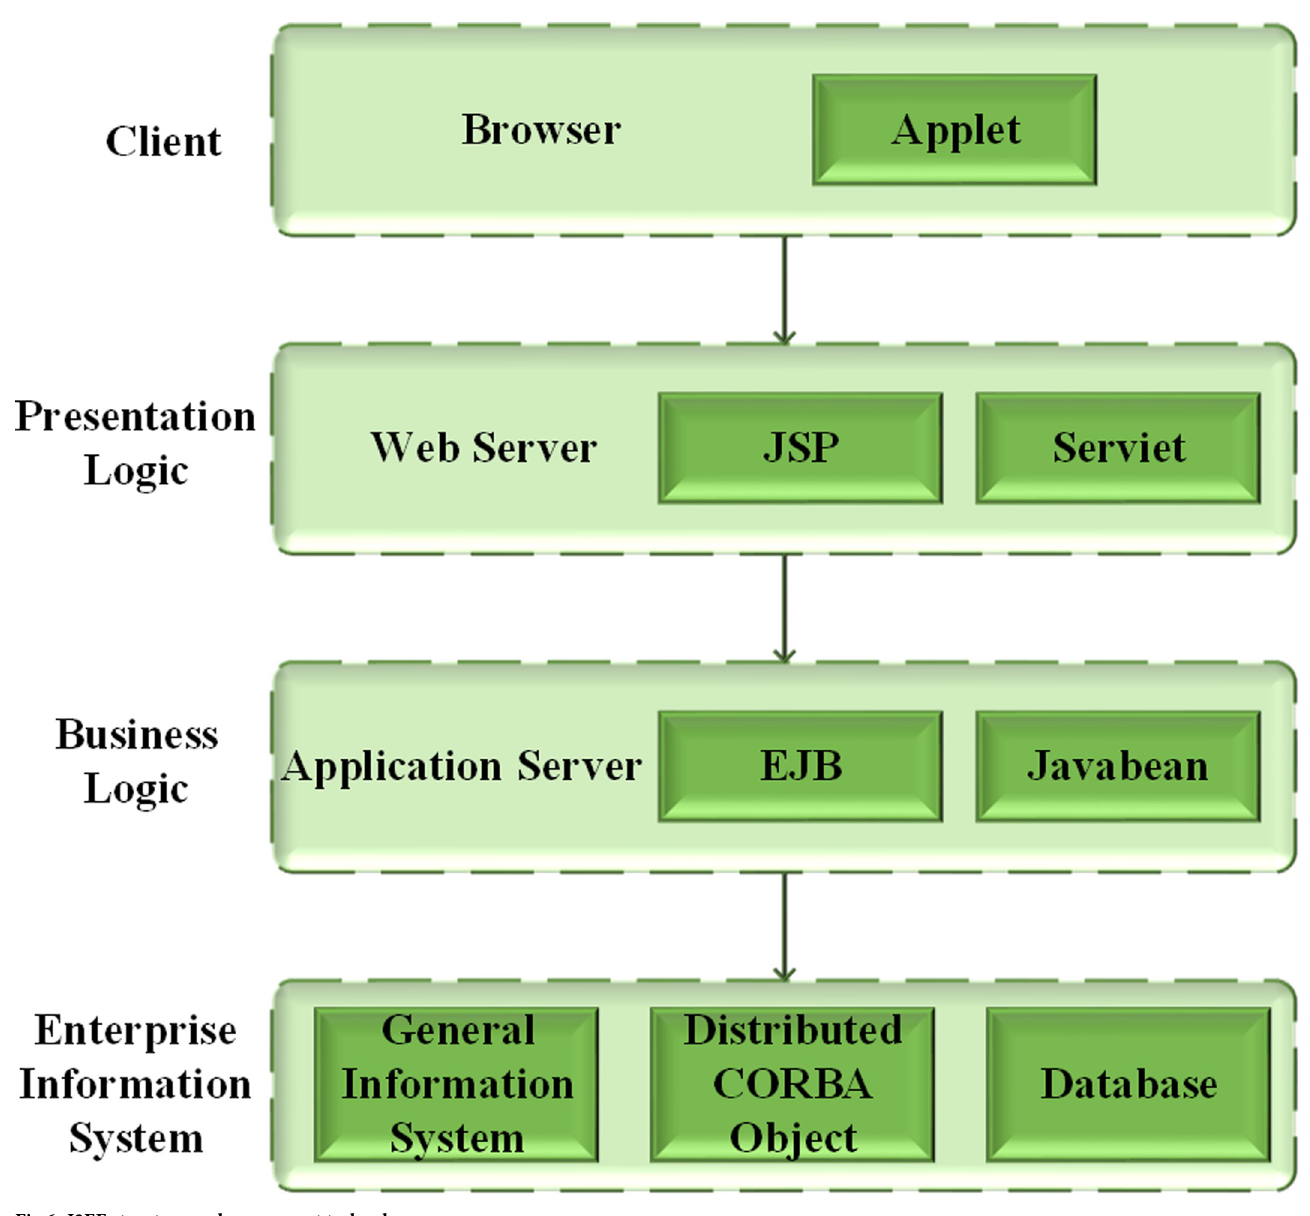
Fig 6. J2EE structure and component